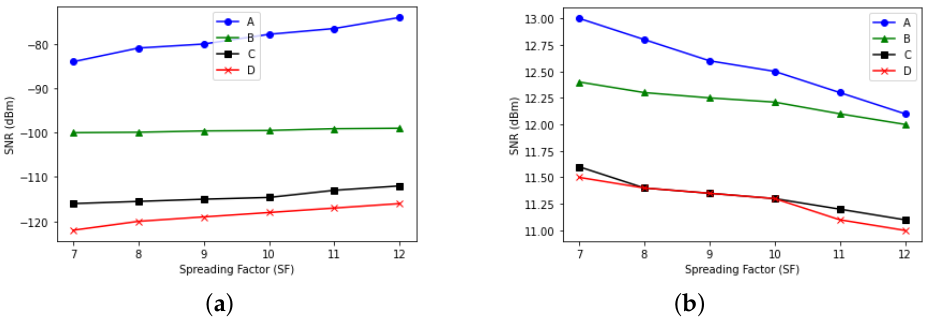
Figure 34. Average RSSI and SNR per point and SF LoRaMESH. ( a ) RSSI. ( b )